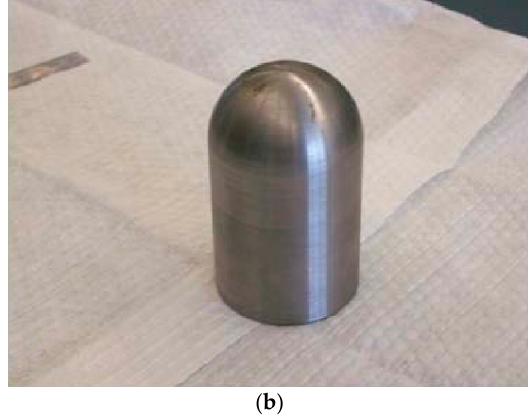
Figure 3. The dented pipe test photo and strain gauges arrangement: ( a ) test equipment, ( b ) semi- spherical indenter, ( c ) dented pipe and strain gauge arrangement, ( d ) schematic diagram of strain gauge arrangement [16].